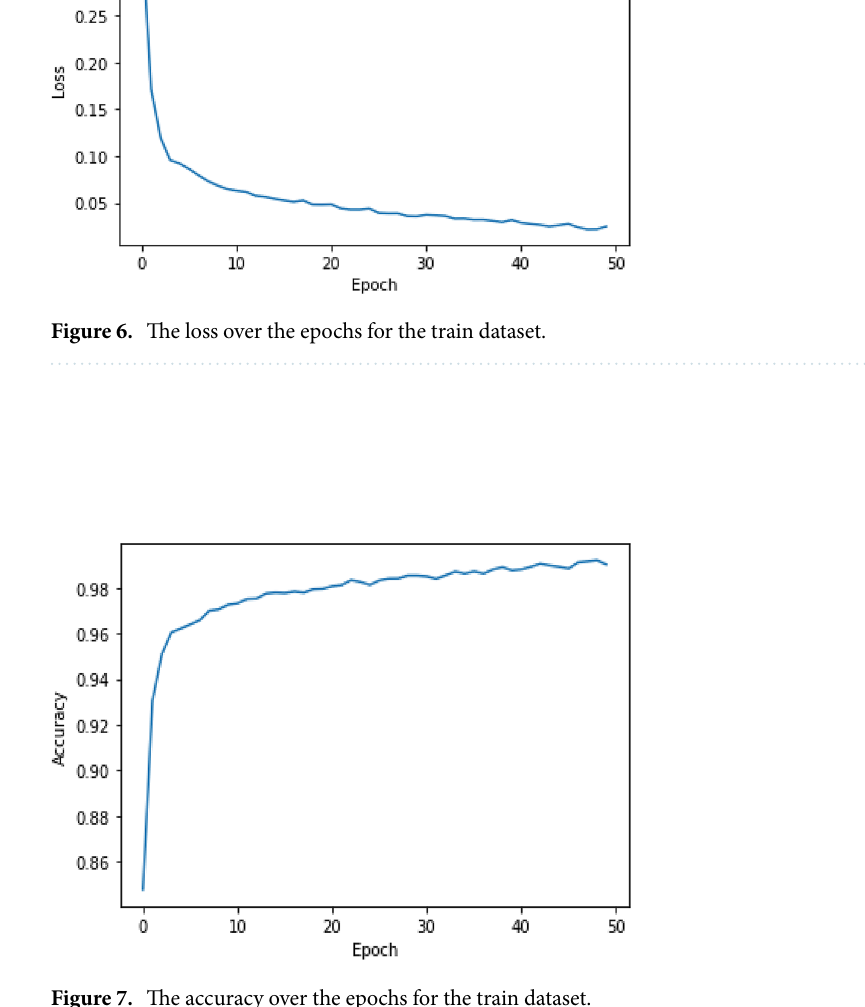
Figure 7. The accuracy over the epochs for the train